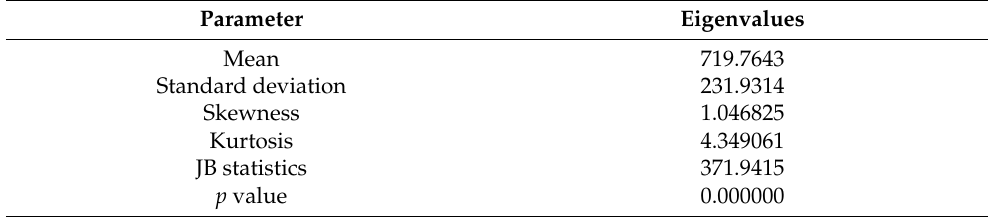
Table 1. Statistics characteristics of